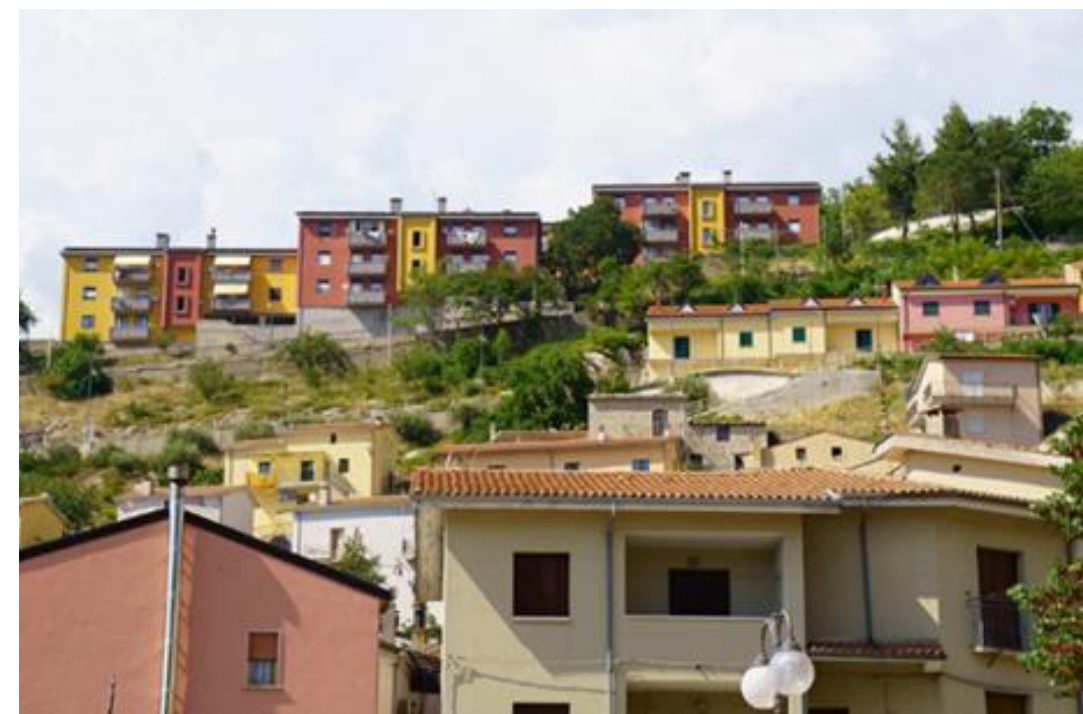
Figure 31. Santomenna: a detail of the new buildings (photos by [35,36]).